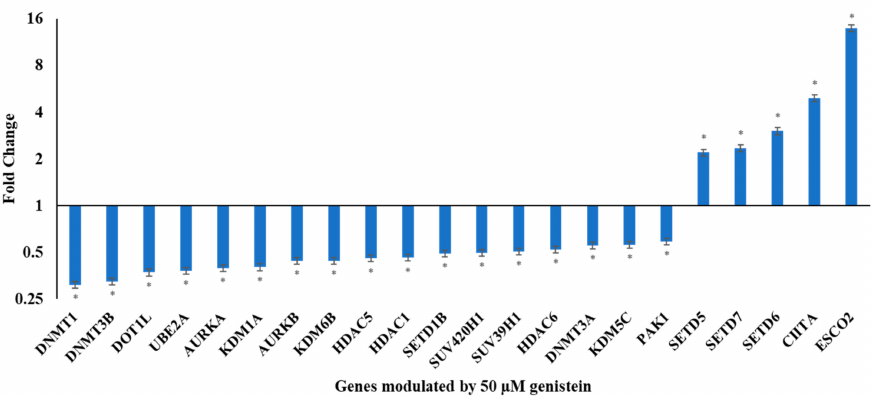
Figure 2. E ff ect of genistein on genes involved in chromatin modification. RQ plot of genes involved in chromatin modification whose expression in HeLa cells is modulated following treatment with 50 µ M genistein for 48 h. Fold change was calculated by ∆∆ CT analysis compared to the untreated control after global normalization. The values are means ± SD of three independent experiments. (* p ≤ 0.05).